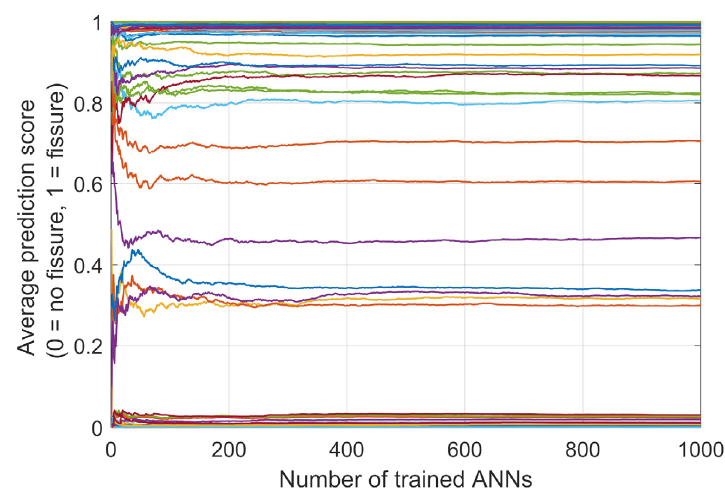
Figure A1. Average prediction score as a function of the number of trained artificial neural networks (ANNs). Each line in the plot represents the prediction score of one intervertebral disc. The average prediction score for each intervertebral disc converges with an increasing number of trained ANNs. The lines have different colors to increase line separation.